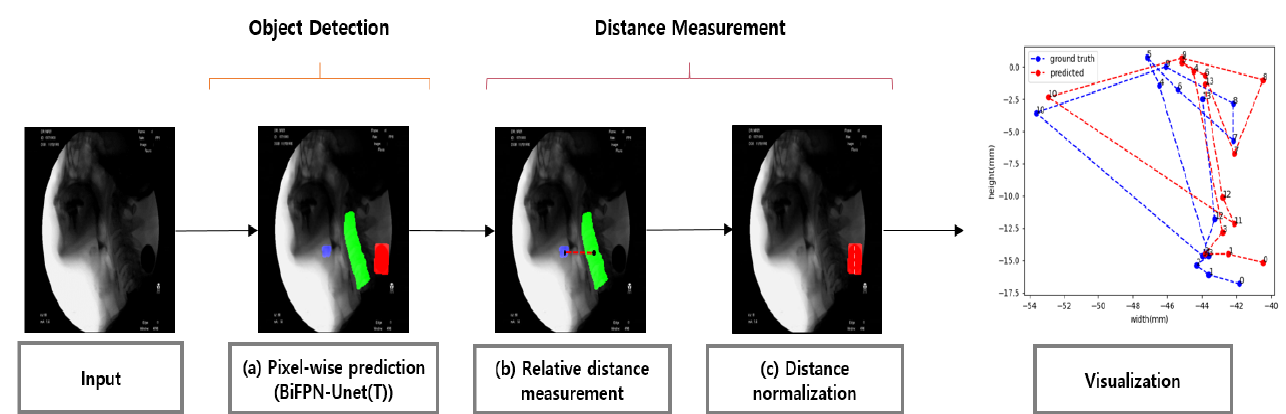
Figure 1. Schematic diagram of the proposed tracking system for the hyoid bone. Each frame of the video is used as an input in the deep learning network. ( a ) Each frame is classified by pixel through a deep learning segmentation model. ( b ) The relative distance between the hyoid bone and the cervical spine is calculated. ( c ) The relative distance obtained in ( b ) is converted to a normalized distance. Finally, the trajectory of the hyoid bone obtained through the above process is